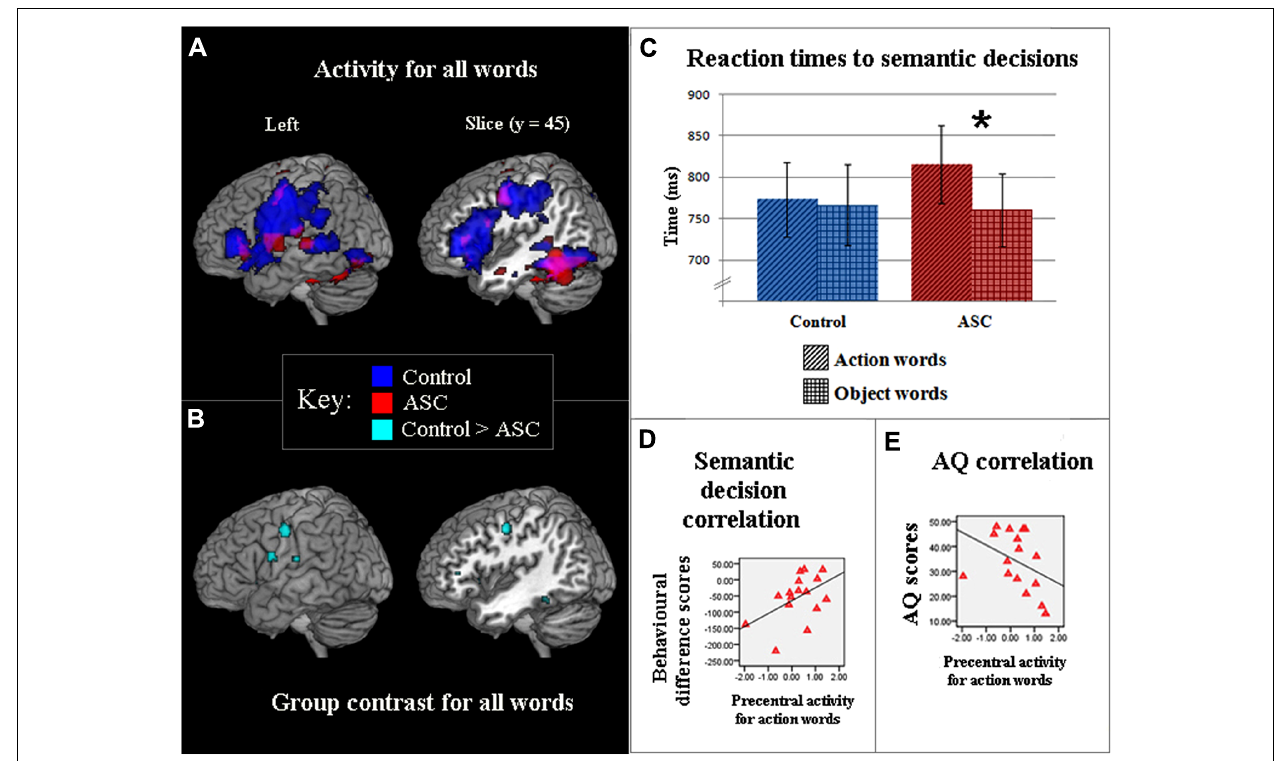
action words and behavioral difference scores in the semantic decision task. Behavioral underperformance in classifying action words was quantified by subtracting response times for matched object-words from those to action-related words, and is significantly correlated with lower activity in the motor system. Motor activation was measured in precentral cortex, at coordinate ( − 50, − 10, 44), where maximal activation was seen in action word reading inTD participants. (E) Significant correlations for ASC participants between activity in the motor system [see (D) ] for action words and AQ scores. Higher numbers reflect increasing number of autistic traits. In (C,D) , values along the x -axis reflect parameter estimates (arbitrary units) reflecting the difference in activation between action words and the baseline condition